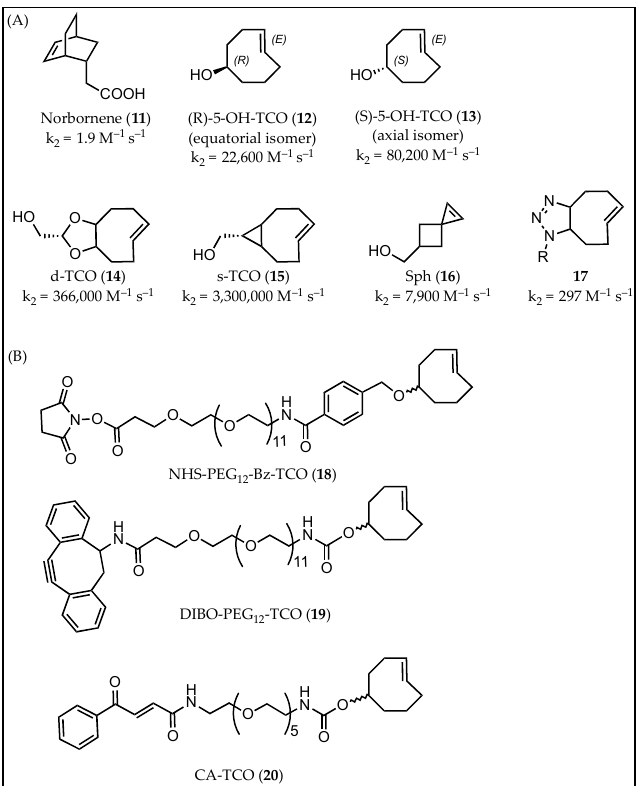
Figure 3. ( A ) Represented dienophiles for IEDDA reaction: 11 [75], 12 – 15 [77], 16 [78], 17 [80]. ( B ) Modified dienophiles for antibody-based pretargeting studies.